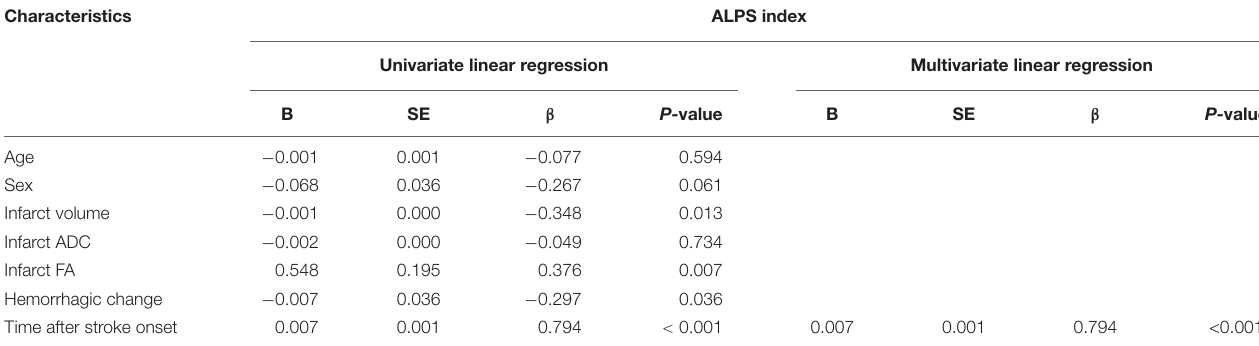
TABLE 4 | Univariable and multivariable linear regression analyses of factors associated with ALPS index. Characteristics